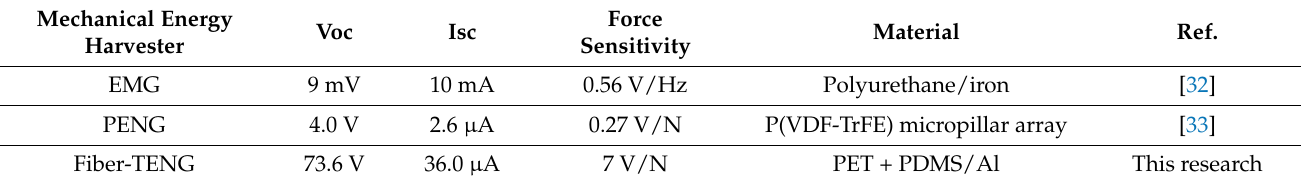
Table 2. Comparison of fiber-based MN-TENG with fiber EMG and